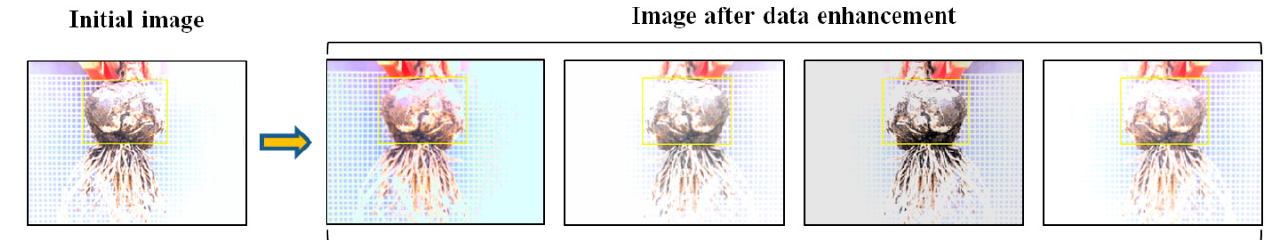
Figure 6. Effect of data